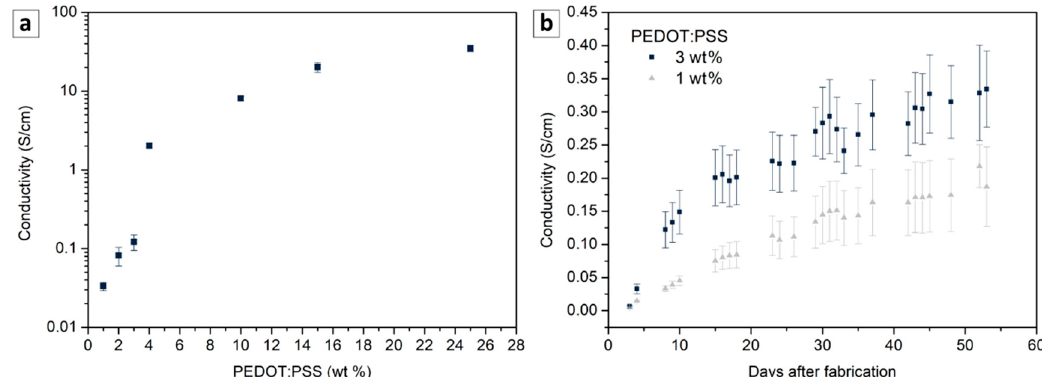
Figure 2. Conductivity of PAni-SnCl 2 -PEDOT:PSS composites. Evolution of the conductivity (measured one week after fabrication) as a function of PEDOT:PSS content ( a ) and as a function of time for two PEDOT:PSS content ( b ).